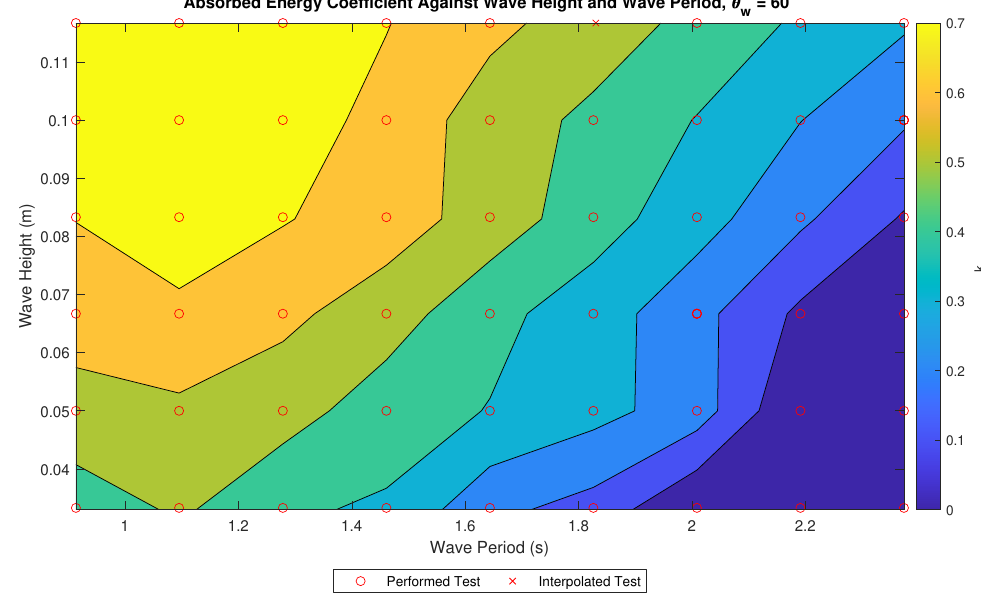
Figure 10. K a against significant wave height and peak wave period. Average Power Produced During Test Against Wave Height and Wave Period,